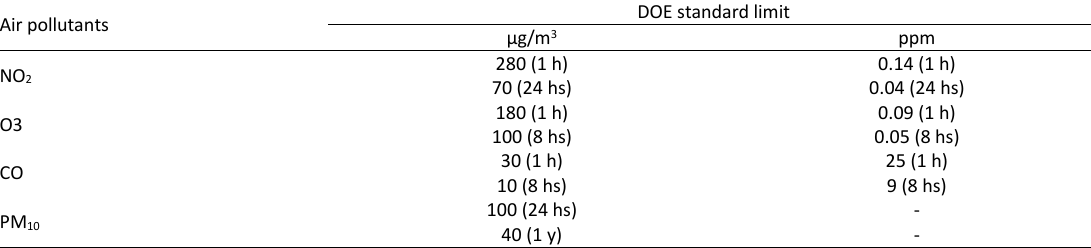
Table 1: Standard limit for air pollutants